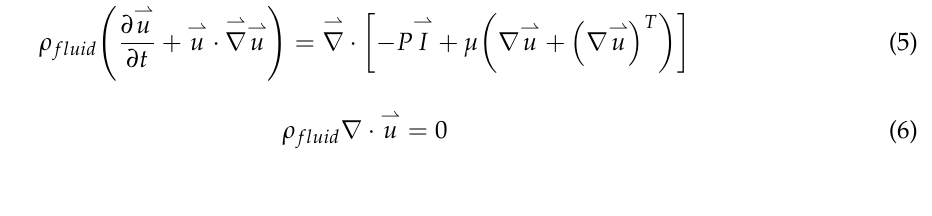
width, h/2 . This 2